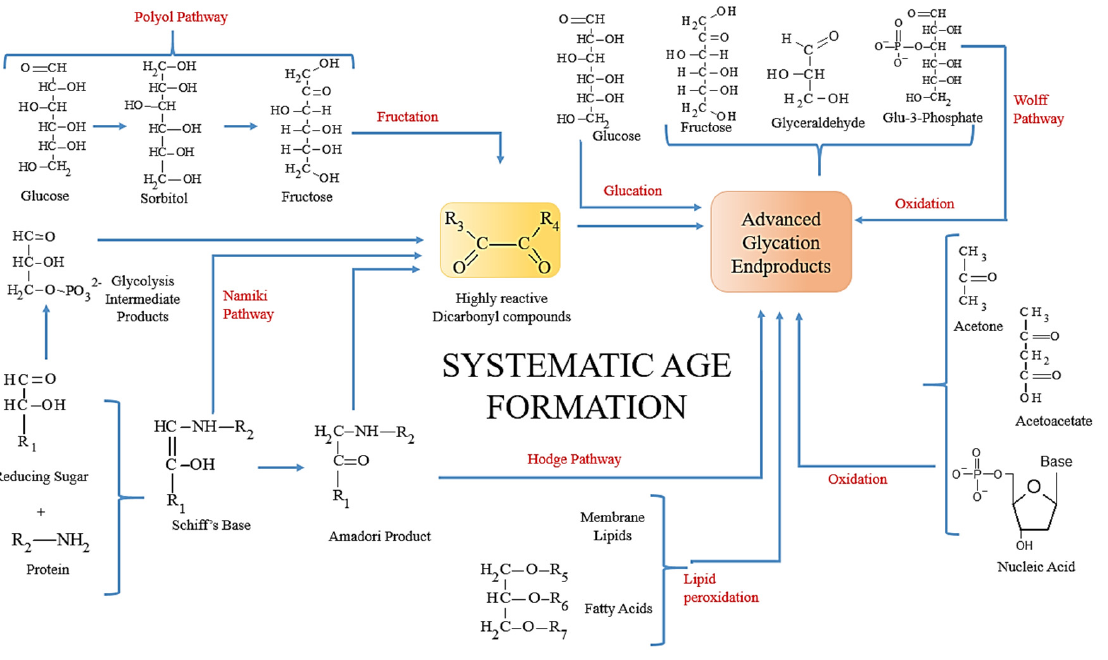
Figure 2. A complex network of AGEs formation: AGEs are formed through various pathways under oxidative and carbonyl stress conditions.